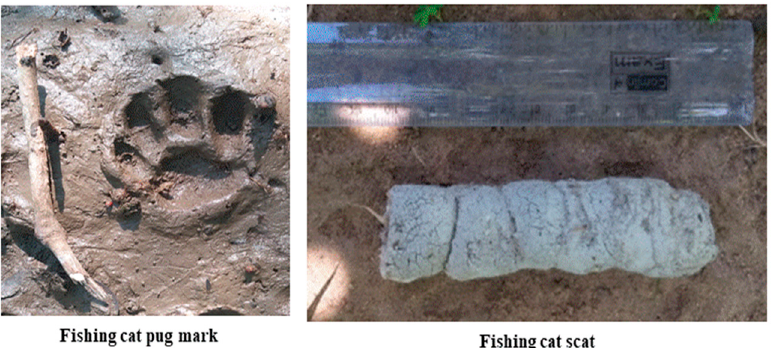
Figure 2. Pugmark and scat of the fishing cat Prionailurus viverrinus , Coringa Wildlife Sanctuary, India.